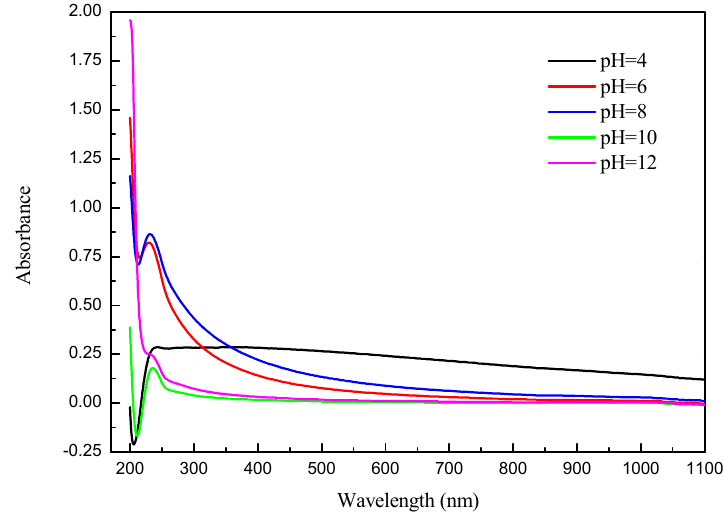
Figure 3. UV spectra of NaOL solution as a function of pH (NaOL: 2 × 10 − 4 mol/L).